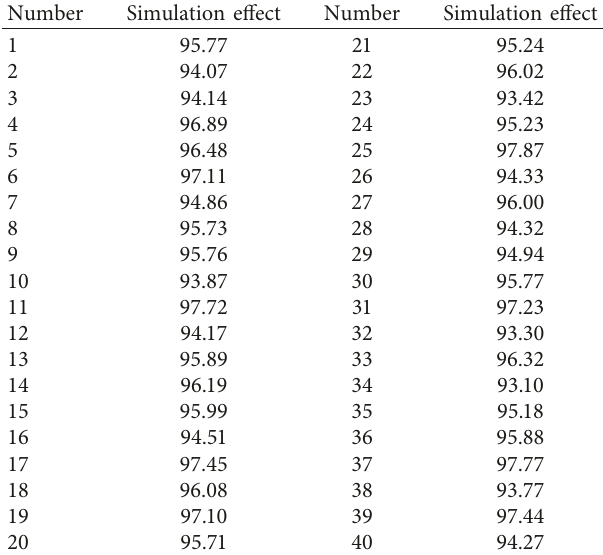
Table 1: Simulation effect of sustainable development garden landscape design system based on data mining and virtual reality.